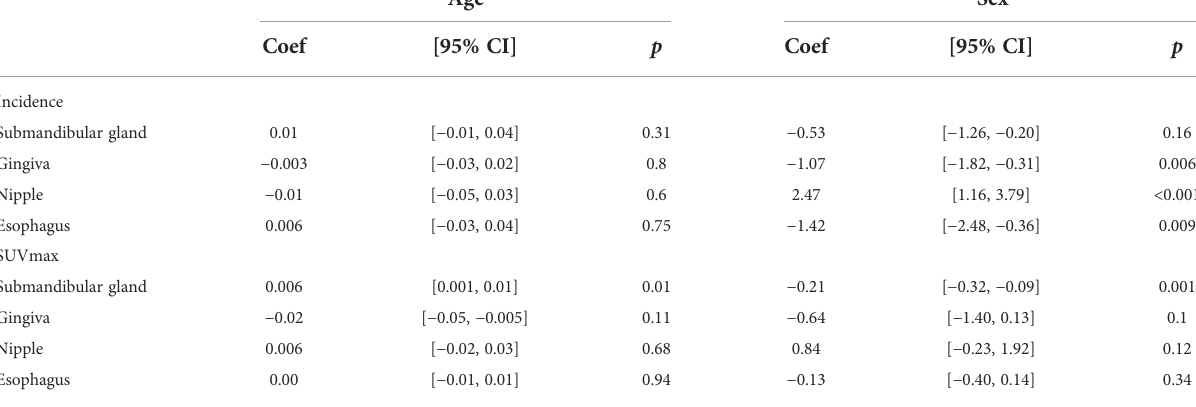
TABLE 3 Main effects of age and sex on the 68 Ga-FAPI-04 uptake.